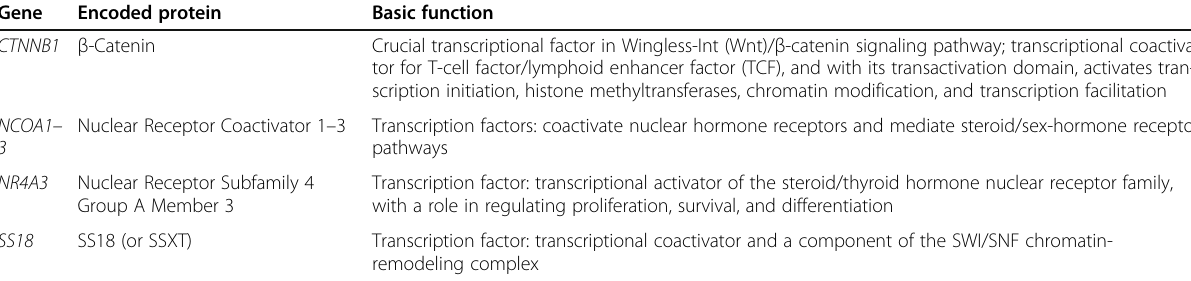
Table 2 Function of partner genes related to GREB1 rearrangement Gene Encoded protein Basic